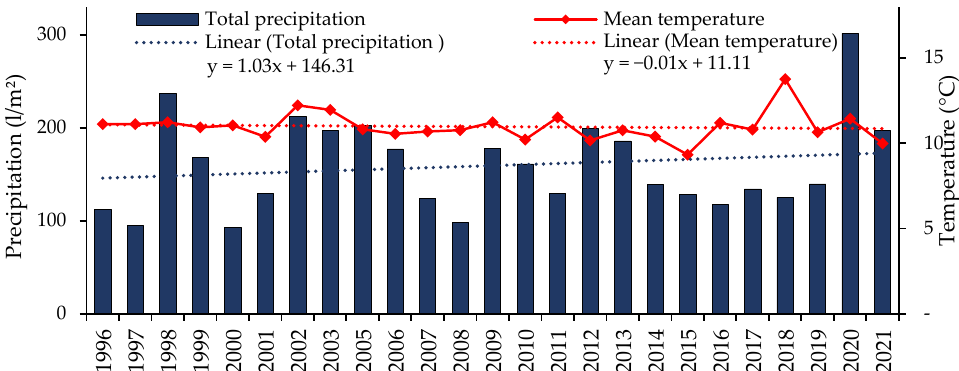
Figure 3. Mean temperature (°C; red line), total precipitation (L/m 2 ; blue bars) of the observation period (GS 30 to GS 77) from the survey period at the trial location. Dotted lines describe the linear regressions of temperature and precipitation.